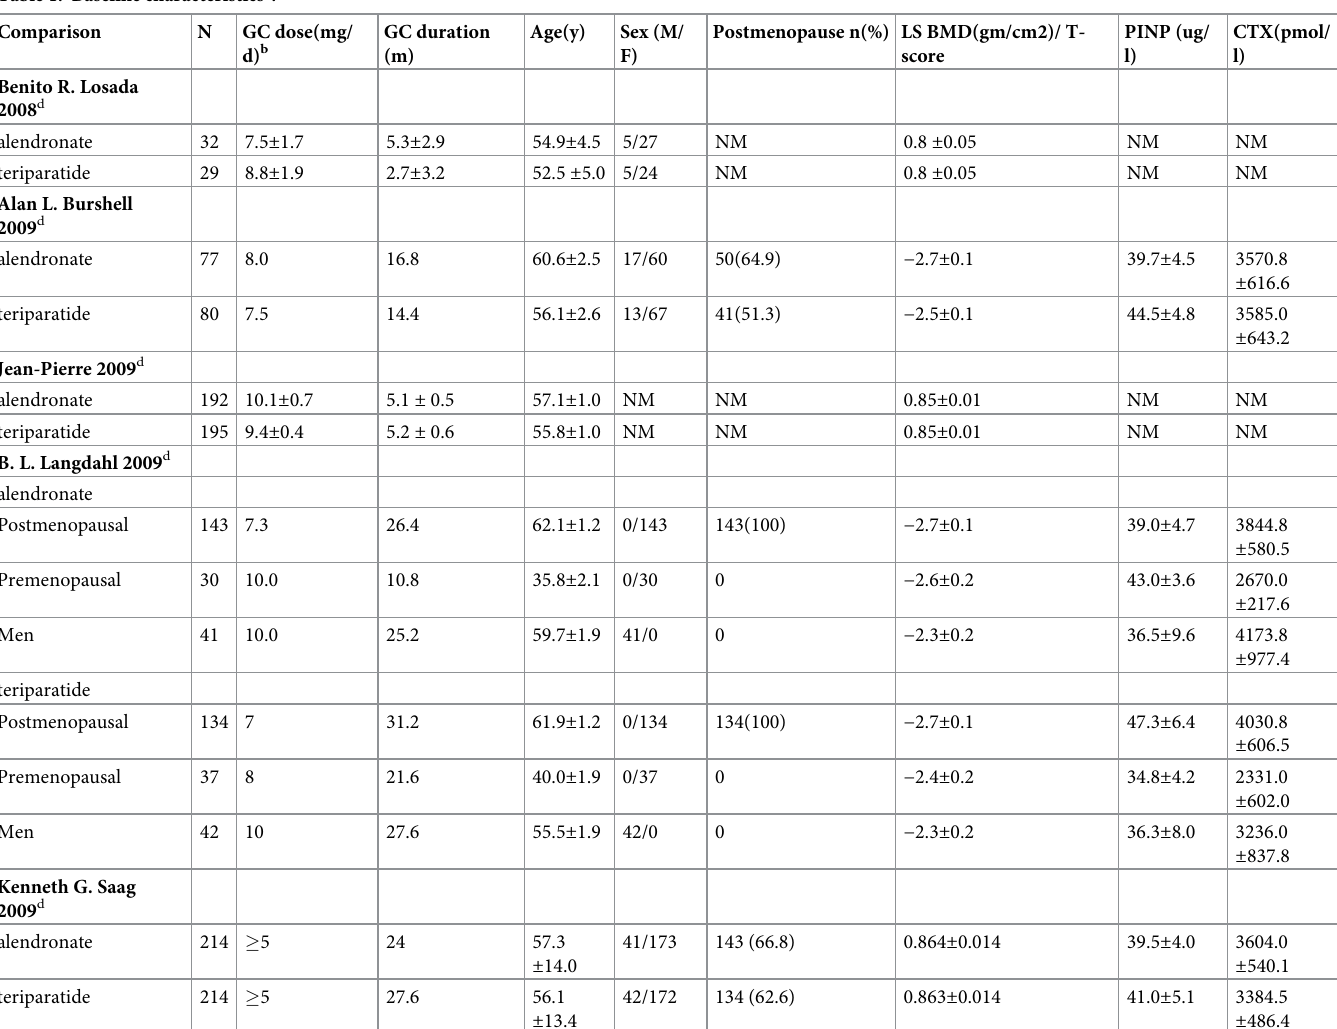
Table 1. Baseline characteristics a